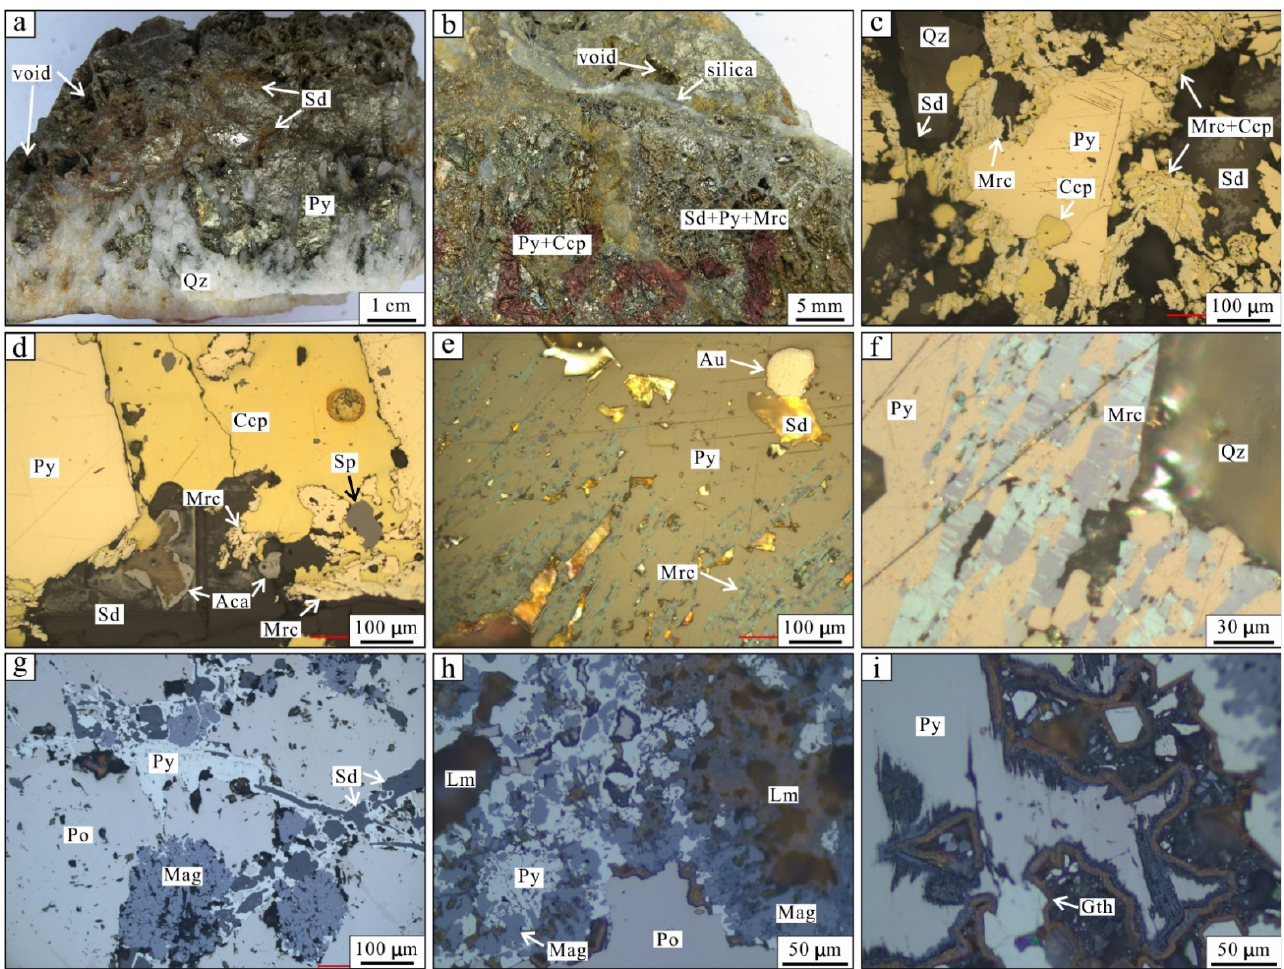
Figure 3. Hand samples from the supergene enrichment zone of the Linglong gold deposit ( a , b ) and their photomicrographs under reflected light ( c – i ). The ores are vuggy ( a ) and contain the primary pyrite-chalcopyrite-pyrrhotite and the secondary marcasite-acanthite and siderite ( c – f ) and magnetite-limonite-goethite ( g – i ) assemblages that are commonly cemented by silica colloids ( b ). Marcasite grains are usually tabular and are recognizable by their polysynthetic twinning and pleochroism (blue and brownish gray) under crossed polarized reflected light ( e , f ). Aca: acanthite; Au: visible gold grain; Ccp: chalcopyrite; Gth: goethite; Lm: limonite; Mag: magnetite; Mrc: marcasite; Po: pyrrhotite; Py: pyrite; Qz: quartz; Sd: siderite; Sp: